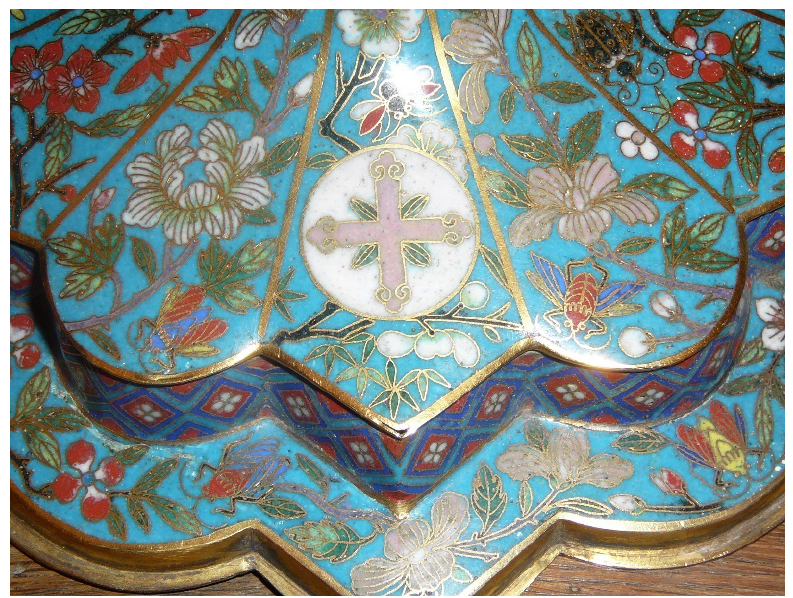
Figure 7. Chalice (detail of the upper side of the base) of Figure 3. Photo: Musée départemental d’art religieux de Sées.